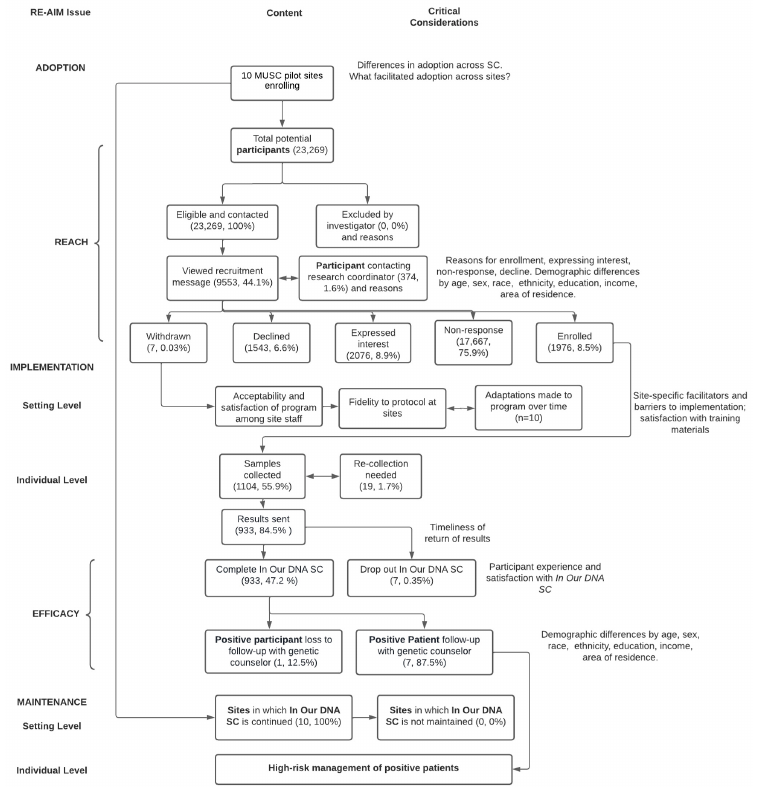
Figure 1. Consort Diagram. Adapted from Glasgow and Chambers (2012). Developing Robust, Sustainable, Implementation Systems using Rigorous, Rapid, and Relevant